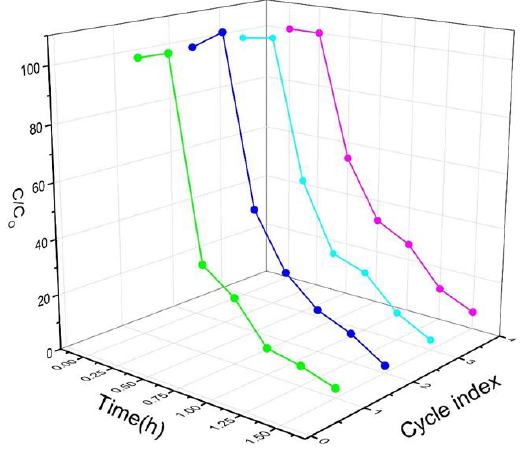
Figure 8. Cycling degradation curves of NiO(10%)/NiTiO 3 nanofiber films on the degradation of 5 mg/L RhB.